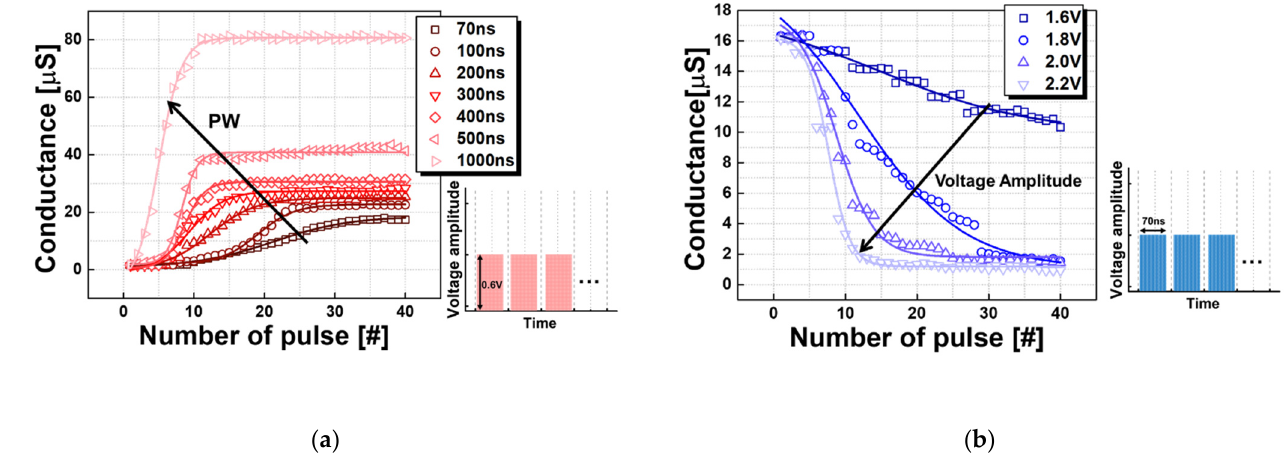
Figure 3. Potentiation and depression characteristics of the (GeTe/Sb 2 Te 3 ) 16 iPCM with identical pulses. ( a ) Potentiation characteristics of pulses fixed at 0.6 V with different PWs. ( b ) Depression characteristics for pulses fixed at 70 ns with different voltage amplitudes.